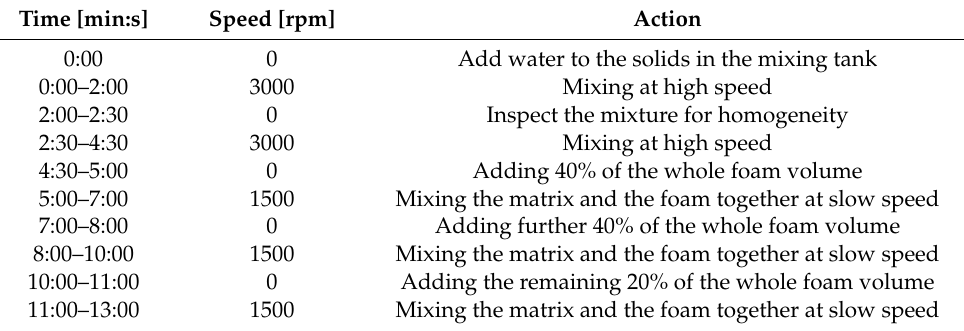
Table 4. Foam concrete mixing procedure.